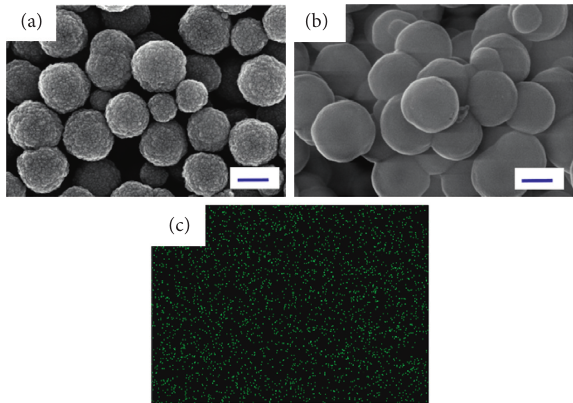
Figure 9: FT-IR spectra of the synthesized Fe PW 10 nanoparticles in comparison with starting materials.